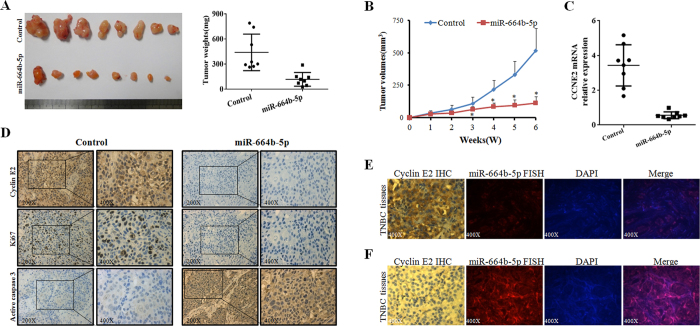
Effect of miR-664b-5p on tumour growth in vivo.(A) The gross morphology of tumours and the final xenograft tumour weights measured on day 42 after injection of tumour cells. (B) Effect of miR-664b-5p on tumour growth in vivo. Growth curves of HCC1937 subcutaneous xenograft tumours treated with miR-664b-5p or miR-NC. Tumour volumes were calculated as (long axis × short axis2)/2; n = 8 per group. (C) qRT-PCR detection of CCNE2 mRNA expression in two groups of tumour xenografts. (D) Representative images of the expression of cyclin E2, Ki67 and active caspase-3 in two groups of tumour xenografts determined by IHC. (E,F) Representative images of cyclin E2 high-expression (IHC) and miR-664b-5p low-expression (FISH) (E) or cyclin E2 low-expression and miR-664b-5p high-expression (F) in TNBC patient specimens. *p < 0.05.